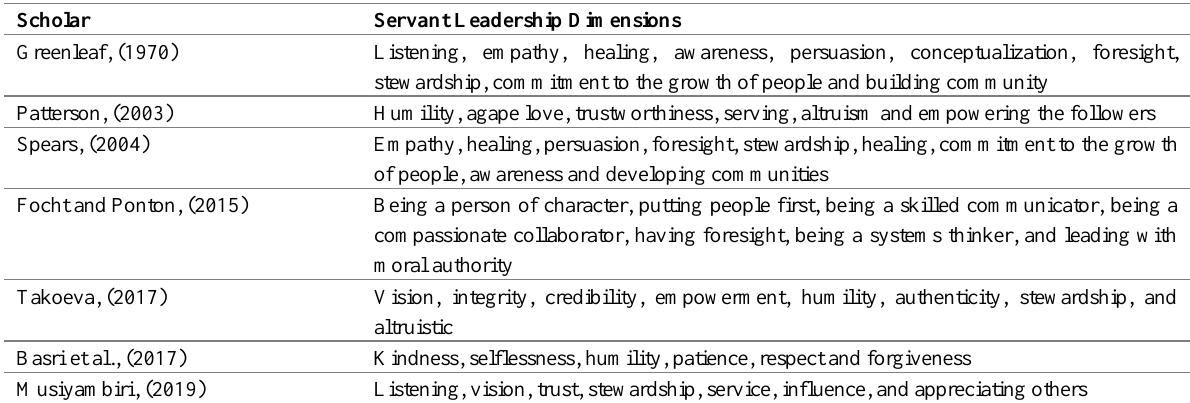
Table 1: Servant Leadership Dimensions from Different